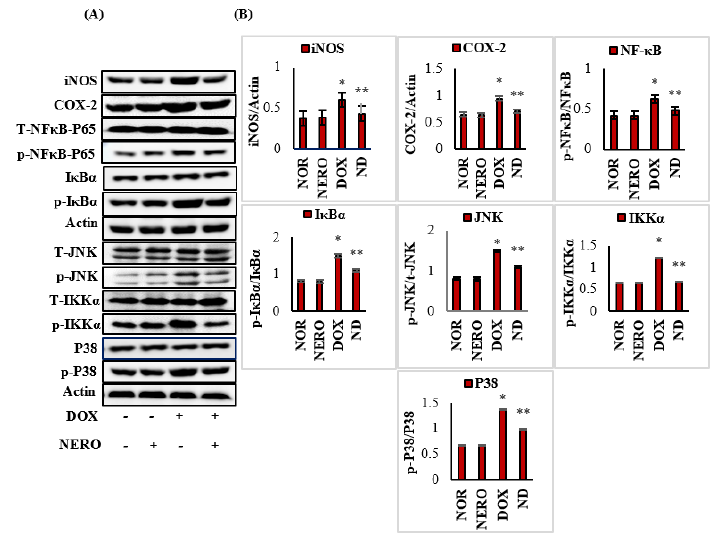
Figure 4. ( A , B ) Western immunoblotting and densitometric analysis for iNOS, COX-2, NF- κ B-P65, p -NF- κ BP65, I κ B α and p -I κ B α , t-IKK α , p -IKK α , t-JNK, p -JNK, P38, and p -P38. The values are expressed as the mean ± SEM ( n = 3); columns do not share a common symbol (*, **) and differ significantly with each other (* p < 0.05 vs. normal control, ** p < 0.05 vs. DOX control). iNOS— inducible nitric oxide synthase; COX-2—cyclooxygenase-2; p -NF- κ B-p65—phospho nuclear factor kappa-B-p65; t-JNK—t-Jun-amino-terminal kinase; p -JNK—p-Jun-amino-terminal kinase; p -IKK α — I κ B kinase- α ; P38-tumor protein; p-P38—phosphorilated p38; NOR—normal; NERO—nerolidol; DOX—doxorubicin; ND—rats administered with a single intraperitoneal dose of DOX and orally treated with NERO.